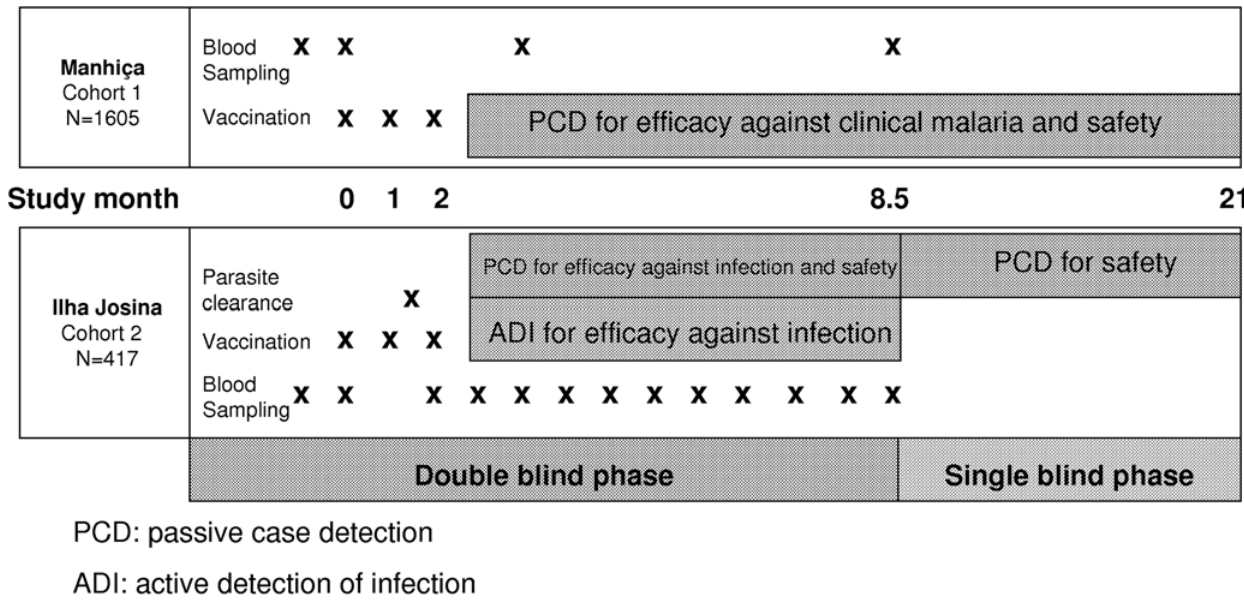
Figure 3. Study design.